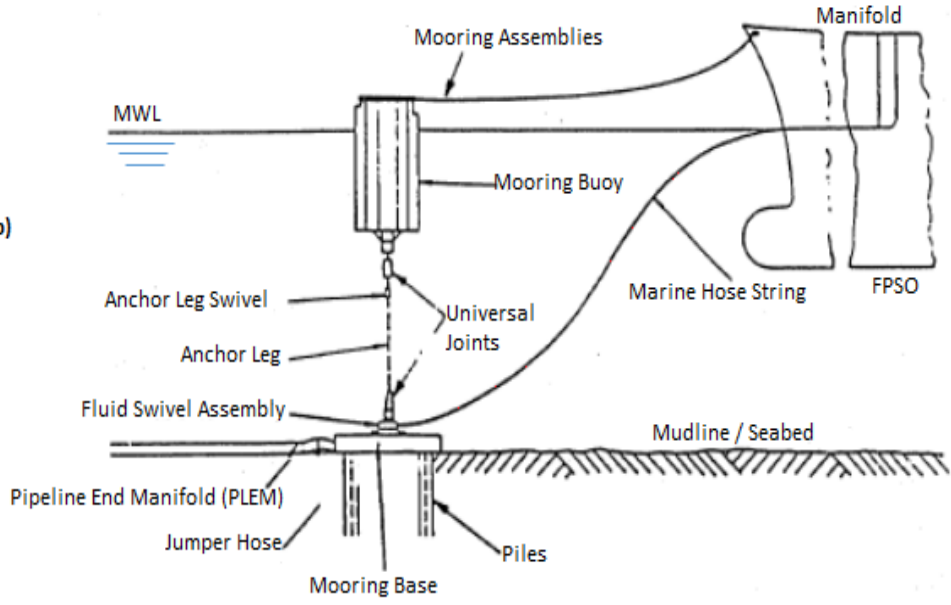
Figure 12. Buoy systems showing ( a ) CALM and ( b ) SALM buoy systems.